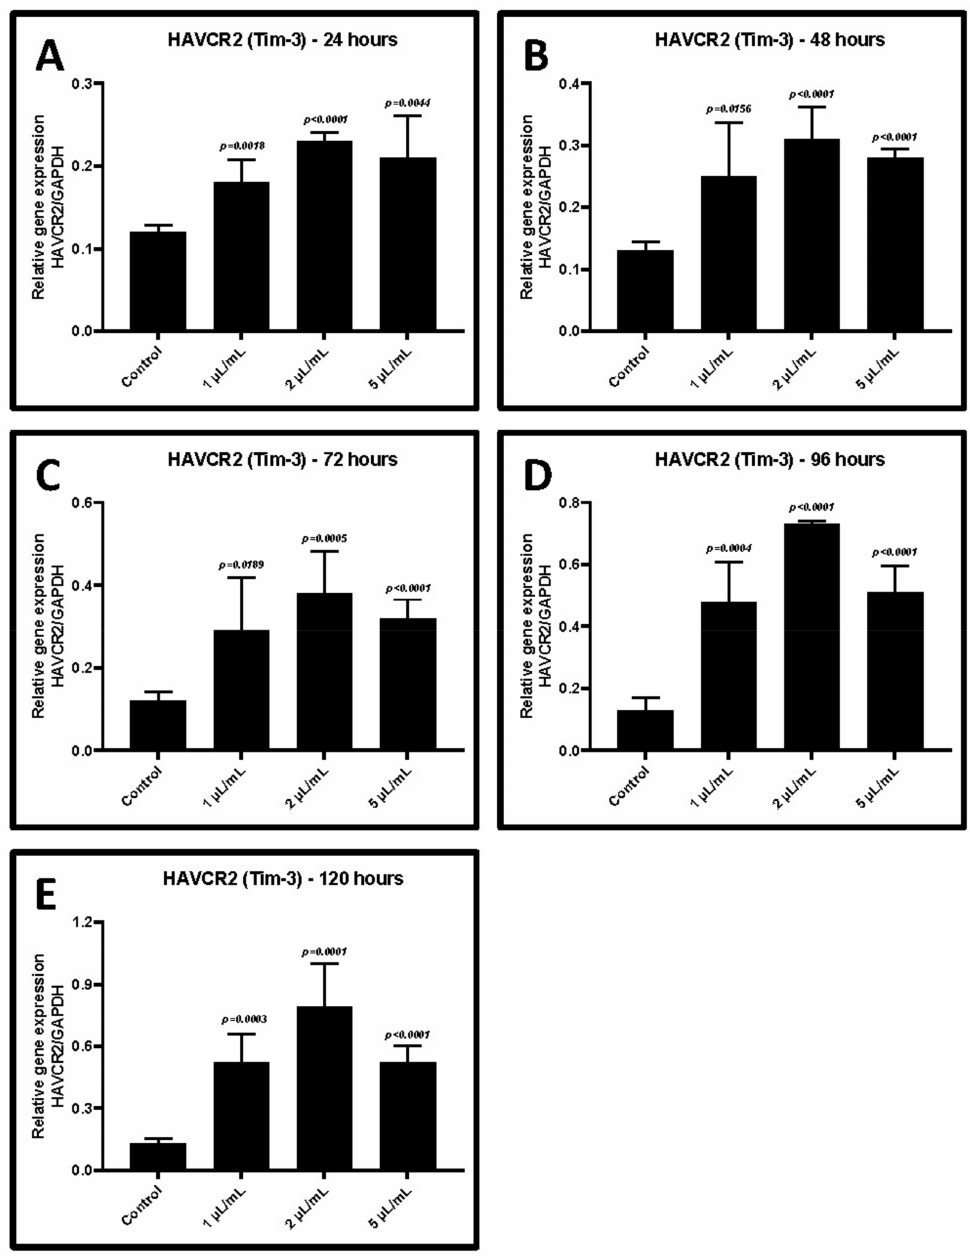
Figure 4. Relative gene expression of HAVCR2 (TIM-3) in CD3+ T lymphocytes treated with different concentrations of GCF (1, 2, and 5 µ L/mL). ( A ) Comparative gene expression of TIM-3 after 24 h of treatment. ( B ) Comparative gene expression of TIM-3 after 48 h of treatment. ( C ) Comparative gene expression of TIM-3 after 72 h of treatment. ( D ) Comparative gene expression of TIM-3 after 96 h of treatment. ( E ) Comparative gene expression of TIM-3 after 120 h of treatment. HAVCR2 (TIM-3) : T-cell immunoglobulin and mucin-domain containing-3, GCF: Gingival crevicular